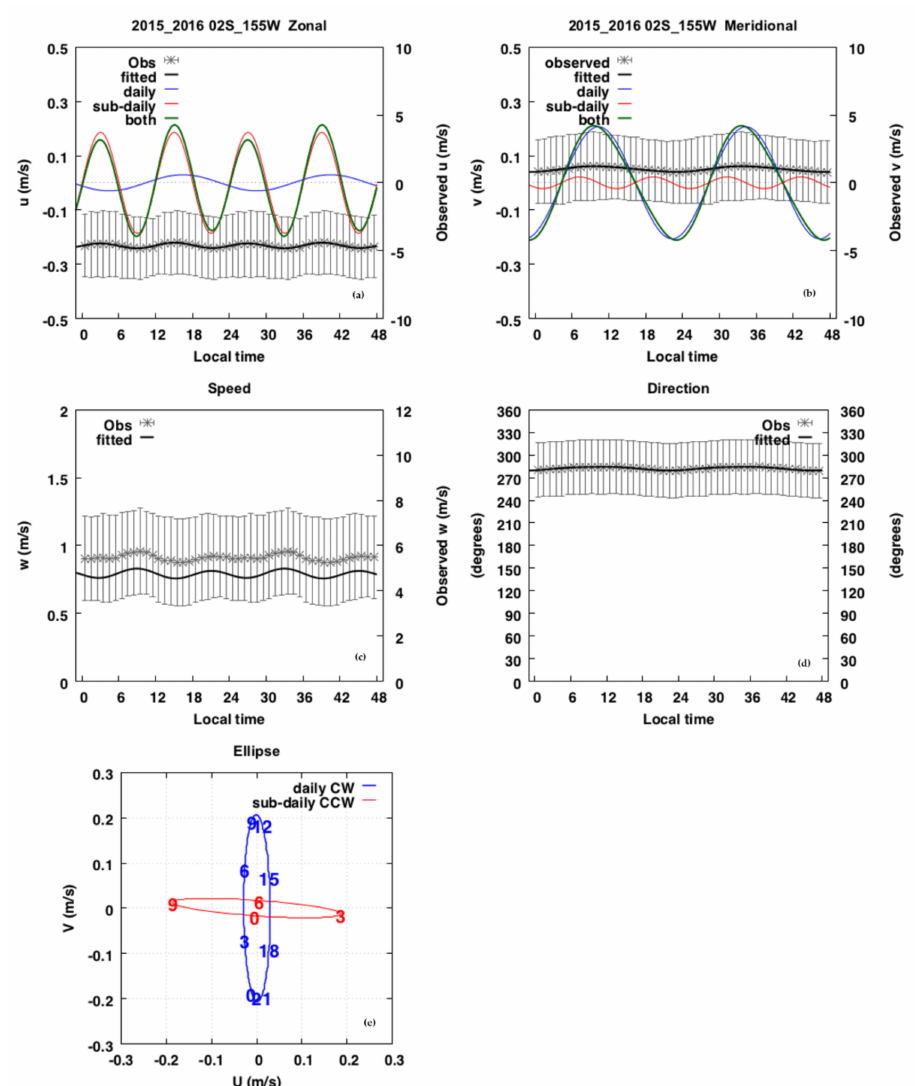
Figure 6. Same layout as Figure 3, except for the TAO-TRITON mooring located at 2S 155W. All hourly data from 2015 are used to solve for the coefficients in Equation (4). The “fitted” mean value at each hour is shown by the connected black line, with the associated ± 1 standard deviation bar. The semidiurnal and diurnal modes are evident for the zonal and meridional wind components. The diurnal (blue) and a semidiurnal (red) wind ellipse spin clockwise and counter-clockwise, respectively, with magnitudes < 0.2 m s − 1